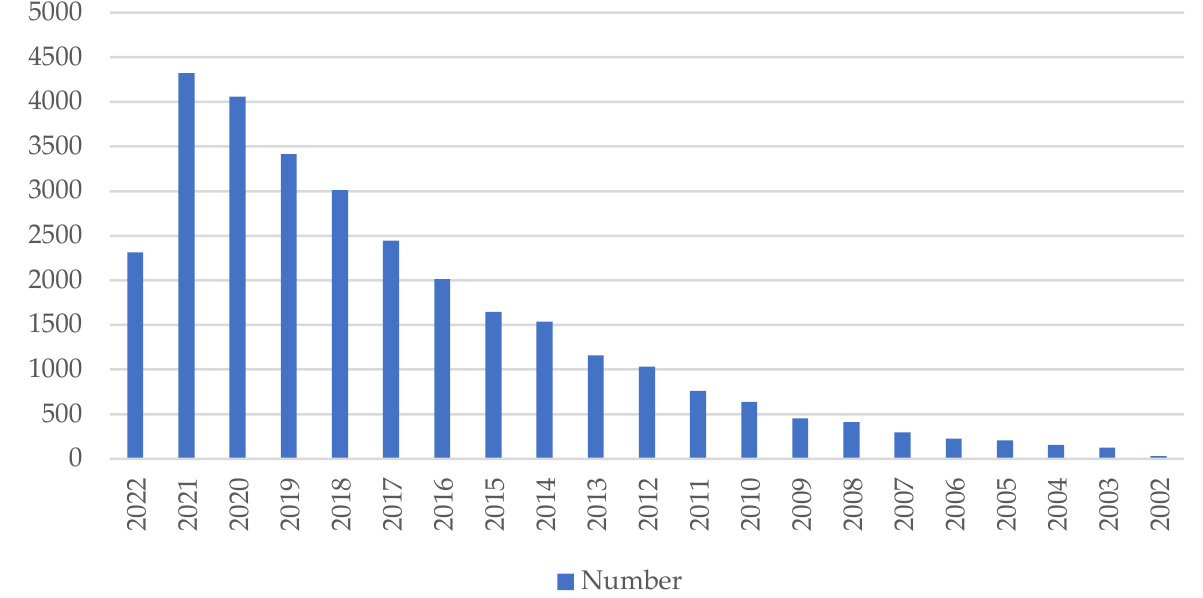
Table 3. Number of publications on BIM